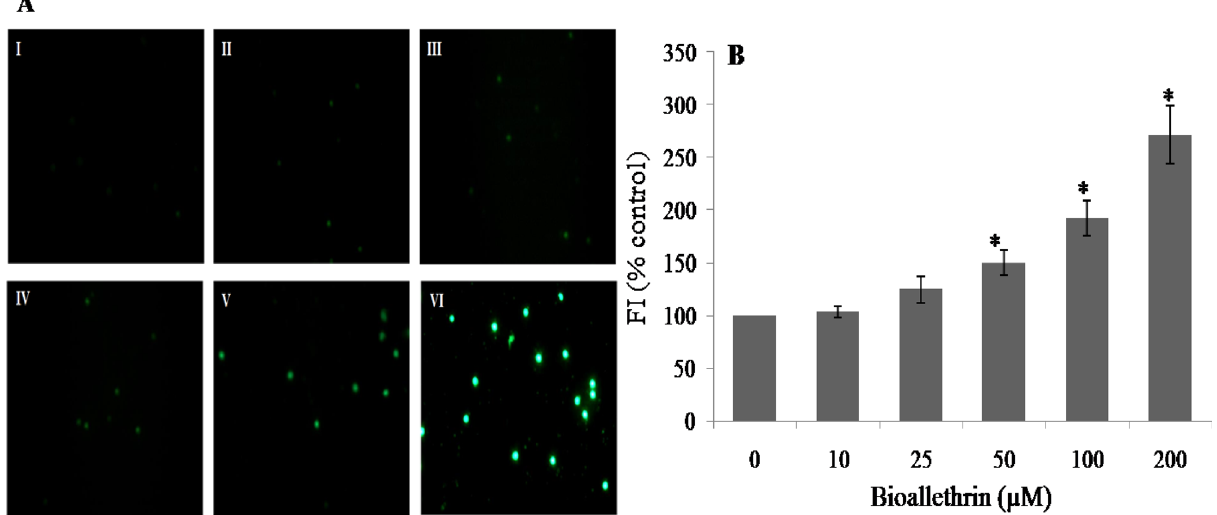
Figure 5. Effect of bioallethrin on ROS generation determined using DCFH-DA. ( A ) Fluorescence microscopic images showing lymphocytes at increasing bioallethrin concentration. I control sample; II–VI lymphocytes treated with 10, 25, 50, 100 and 200 µM bioallethrin, respectively ( B ) Fluorescence intensity of samples, shown in terms of percent control, taking fluorescence of control sample as 100%. Lymphocytes were incubated with bioallethrin for 2 h at 37 °C. Results are ± standard deviation of six different samples. *Significantly different from control at p < 0.05. ROS reactive oxygen species; DCFH-DA dichlorodihydrofluoresceindiacetate; FI fluorescence intensity (arbitrary